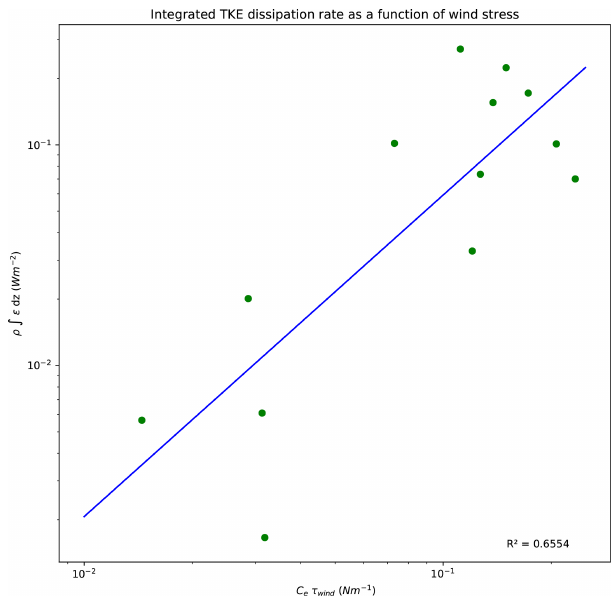
Figure 9. Vertical integral of ε , the TKE dissipation rate, estimated from the SWIFT buoy deployments, versus estimates of wind- driven TKE inputs into the surface ocean. A linear scaling relation- ship was applied to the log of each